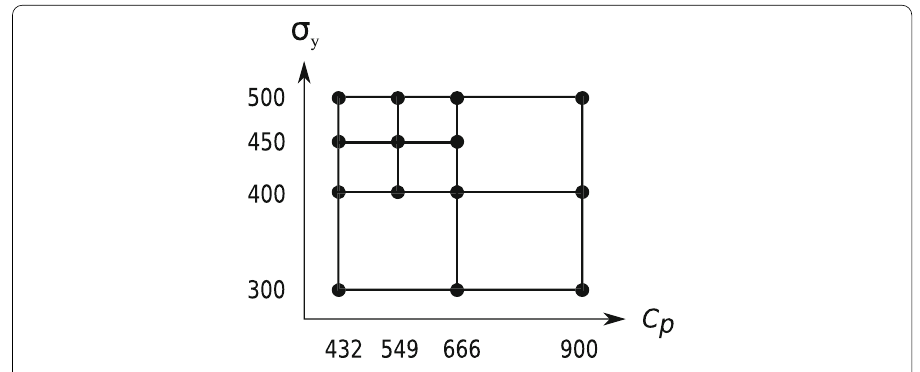
Fig. 14 Snapshots (black circles) selected in the 2D parameter space